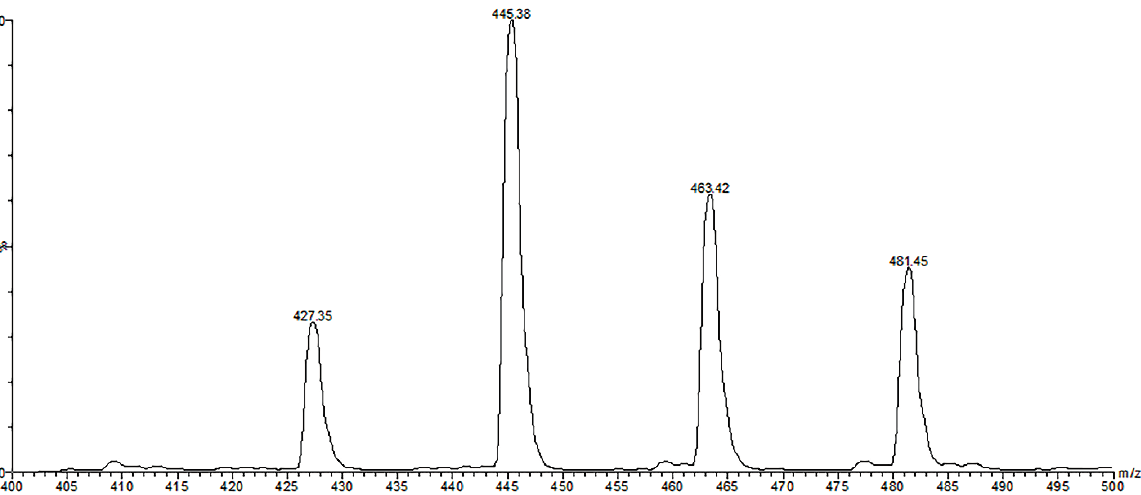
Figure 3. Direct-infusion ESI-MS/MS spectrum of β -ecdysone standard showing [M+H] +